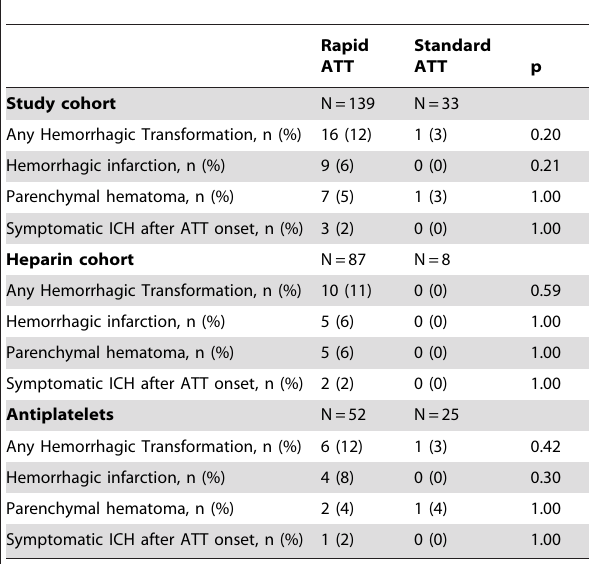
Table 4. Bleeding complications on brain imaging at day